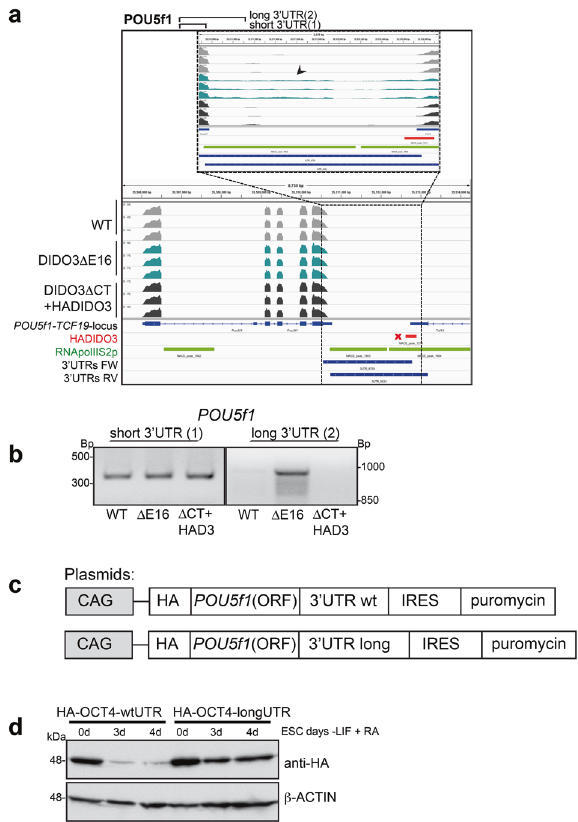
Fig. 3 DIDO transcriptional termination and regulation of POU5f1 RNA. a POU5f1 example gene: IGV image of the POU5f1 locus